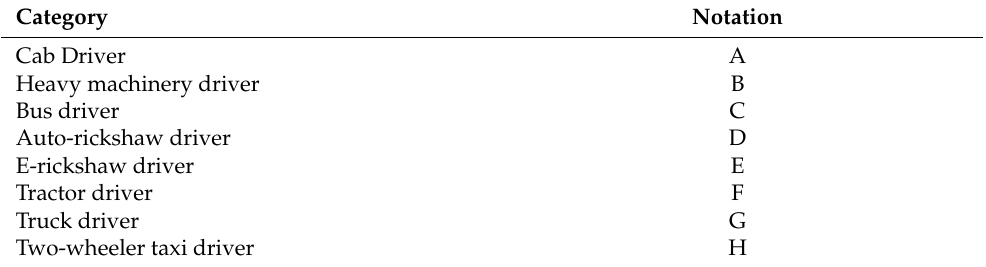
Table 5. Category of professional drivers.